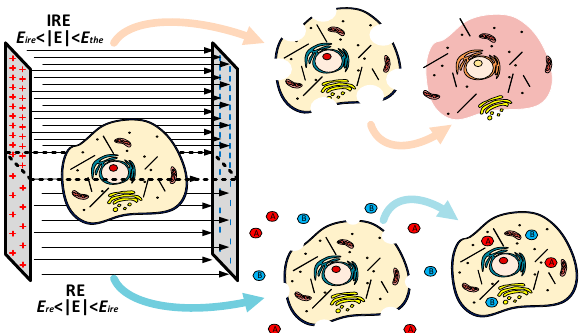
Figure 1. Reversible (RE) and irreversible (IRE) electroporation of an animal cell.